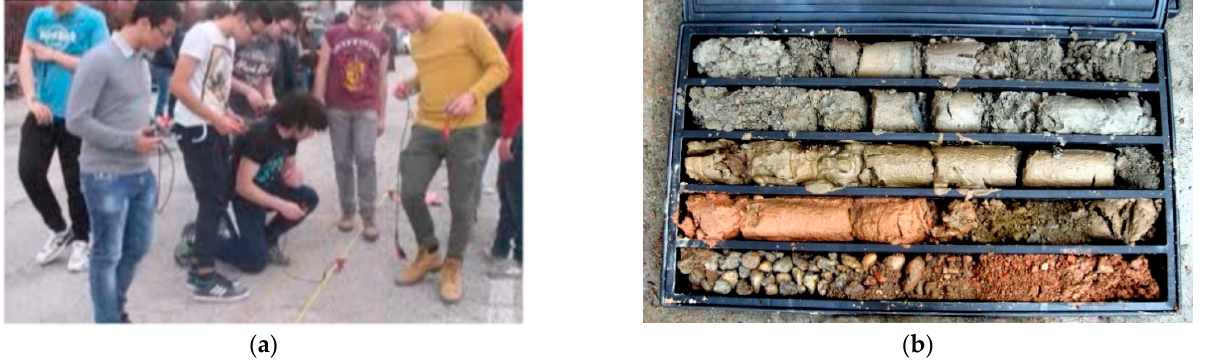
Figure 3. Some examples of outdoor testing: ( a ) students engaged in laying cables and tools for seismic prospecting (year 2016); ( b ) pieces of cores in the cataloging boxes from which students derived the stratigraphic and lithologic information from coring subsoil (year 2016).